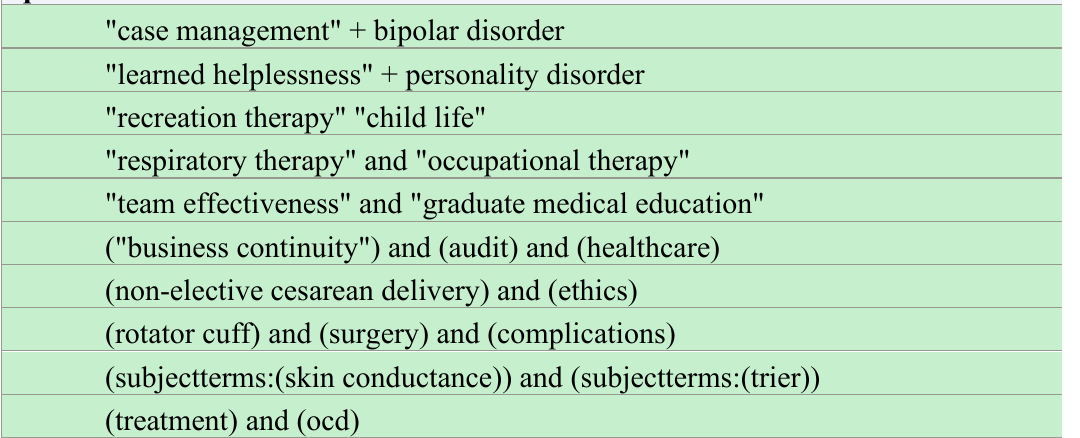
Literature Searches or Clinical Questions in Summon 2018-2019 Examples of search strings that appear to be literature searches or clinical questions